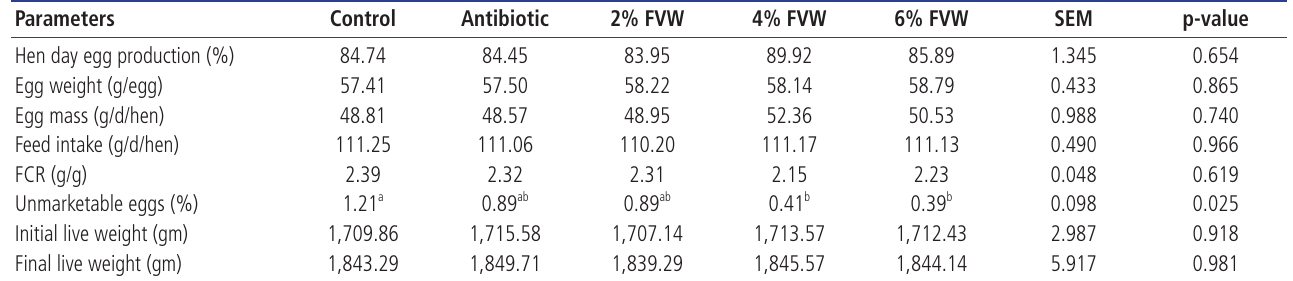
Table 2. Effect of Flammulina velutipes mushroom stem waste (FVW) on performance in laying hens 1)